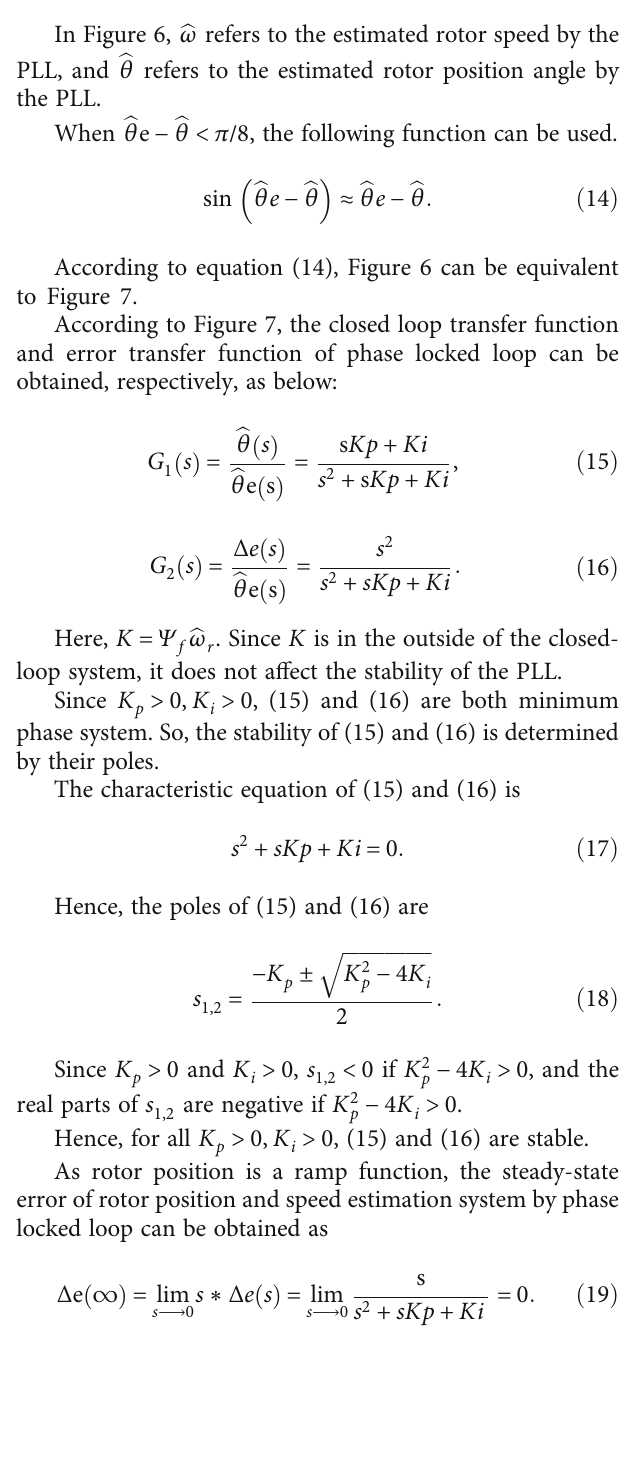
Figure 4: Basic structure of the traditional Luenberger